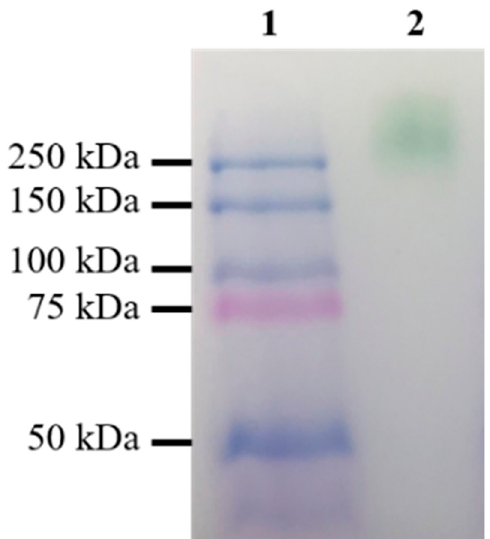
Figure 5. Native-PAGE of the parent-type laccase produced by S. cerevisiae BJ5465. Lane 1, Precision Plus Protein Dual Color S tandards; lane 2, the parent-type LacA.